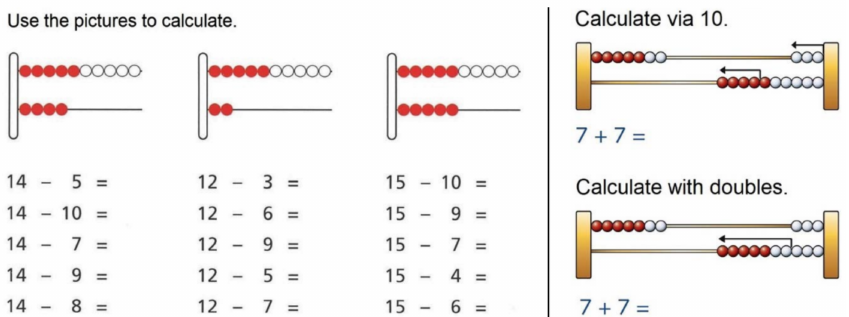
Figure 13. Calculating with the arithmetic rack in W&R (2000s, left, Grade 2, student book 4, p. 14) and RR3 (2010s, Grade 2, student book 4a, p. 16).